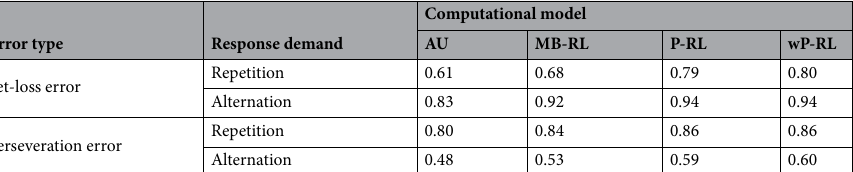
Table 3. Recovery of inter-individual variance of behavioral indices given by the R 2 statistic. AU